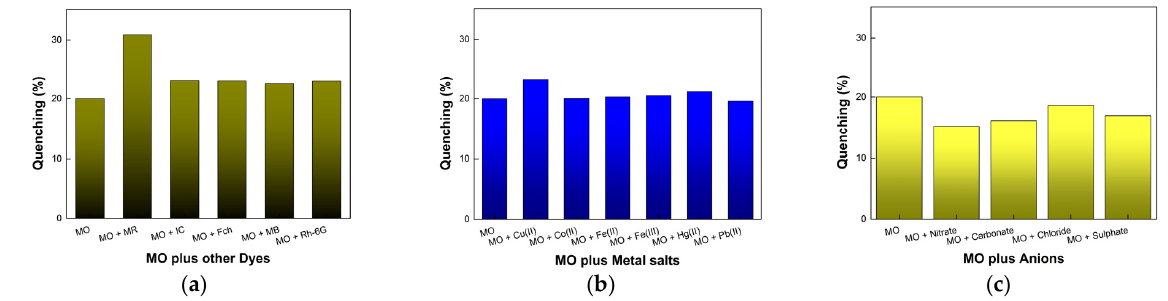
Figure 5. Competitive quenching assays of WP-CDs emission upon addition of MO (10 μ M) and equimolar amounts of possible interferents (other dyes ( a ), metal salts ( b ), and anions ( c )) in phosphate buffer (pH = 7.2). Excitation at λ = 340 nm. All data corrected for IFEs.